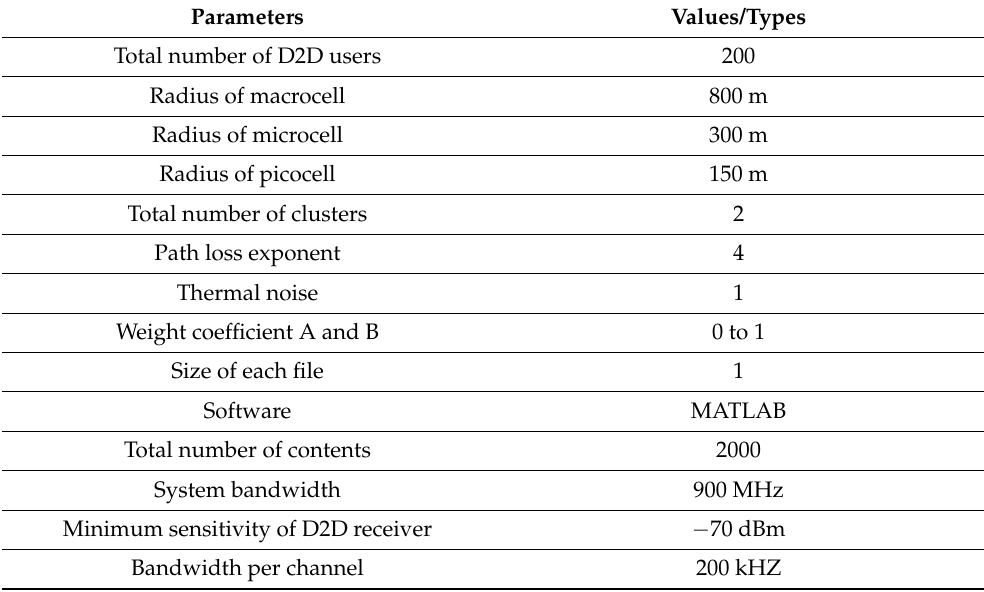
Table 2. Parameters for simulations.